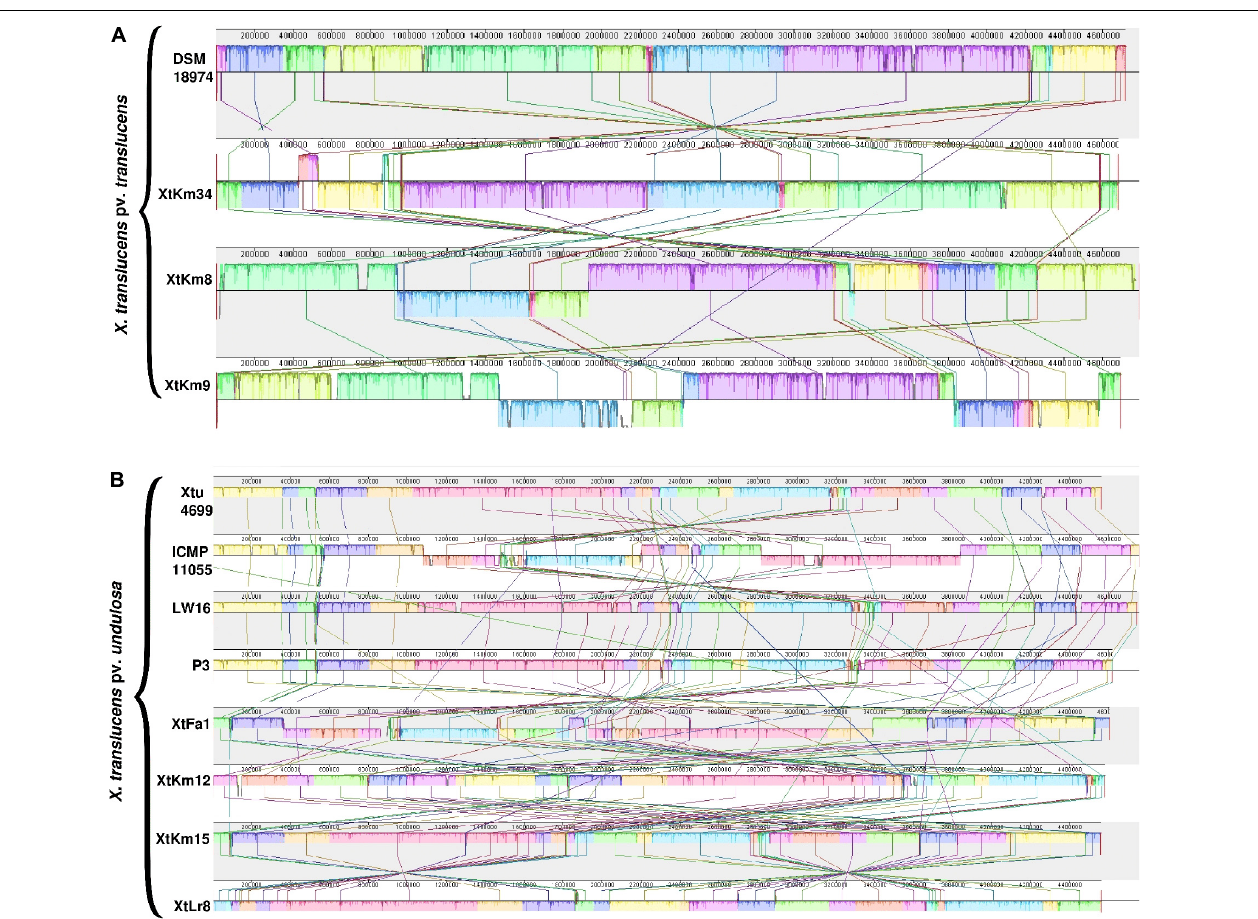
FIGURE 4 | Pairwise alignment among the chromosomal DNA of Xanthomonas translucens strains sequenced in this study and the strains DSM 18974 T and Xtu 4699 as reference genomes for (A) X. translucens pv. translucens and (B) X. translucens pv. undulosa strains, respectively using MAUVE software. Colors show conserved and highly related genomic regions (locally collinear blocks). Blocks shifted below the center line indicate segments that align in the reverse orientation as inversions relative to the respective reference strain. Each contiguously colored region is a locally collinear block, which is a region without rearrangement of homologous backbone sequence. Lines between two genomes trace each orthologous locally collinear block.